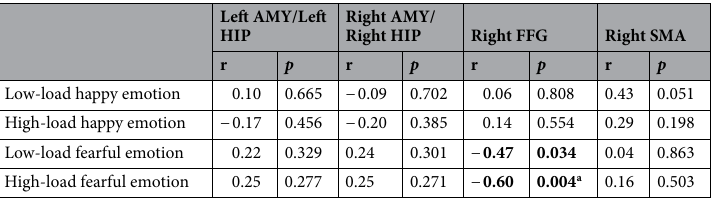
Table 3. Correlation between mfALFF and FER accuracy of patient group. Significant values are in [bold]. a Significantly correlation after Bonferroni adjustments ( p <